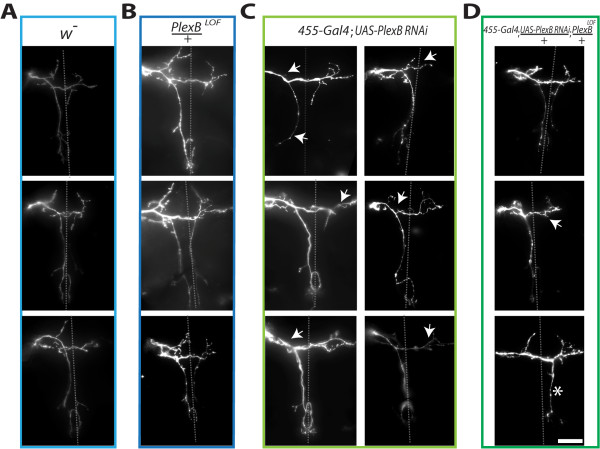
PlexinB knockdown decreases axonal complexity. A, Wildtype flies have a stereotyped pSc axonal branching pattern. B, PlexBLOF/+ do not have axon guidance errors and have wildtype branching patterns. C, Reduced PlexinB expression in pSc neurons results in fewer branches, and an overall decrease in arbor growth. Arrows denote missing stereotypical skeleton branches of the pSc arbor that normally occur in wildtype flies. D, Combining PlexinB RNAi with PlexBLOF/+ phenocopies the 455-Gal4; UAS-PlexB-RNAi pSc axons, and does not induce axon guidance errors. Dotted lines represent the midline and the scale bar is 50 μm.